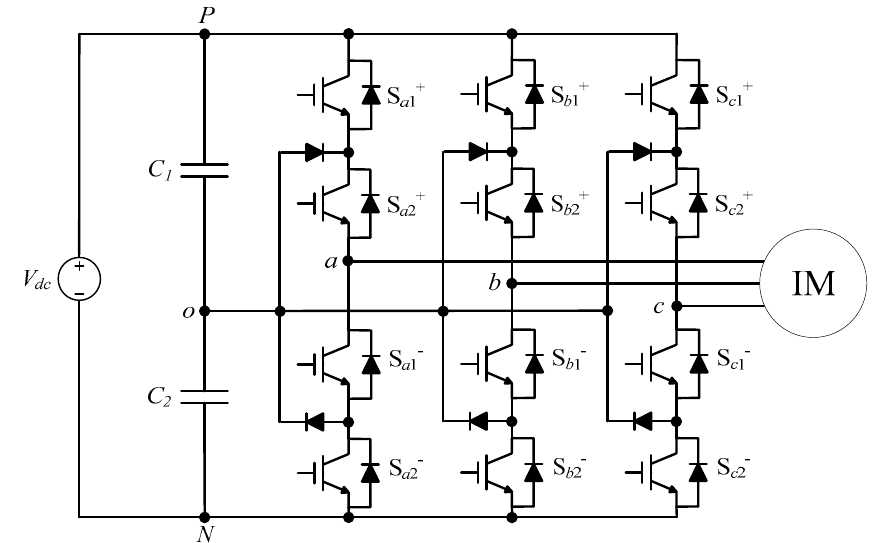
Figure 2. Framework for three-level NPC inverters .